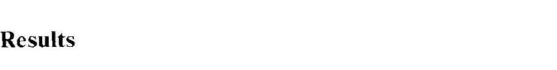
Figure 1. The relationship between serum neopterin levels and Ga-Tf binding in 28 untreated Parkinson's disease patients; (+) High binders (r=0.74, p<O.OOl), (~]) Low binders (r= 0.61. p<0.02). Comparison between regression lines: Slopes (F=2.53, p>0.05), Elevations (F = 99.92, p<O.OOl). and PD plasma by radioimmunoassay (lMMUtest, Henning-Berlin,